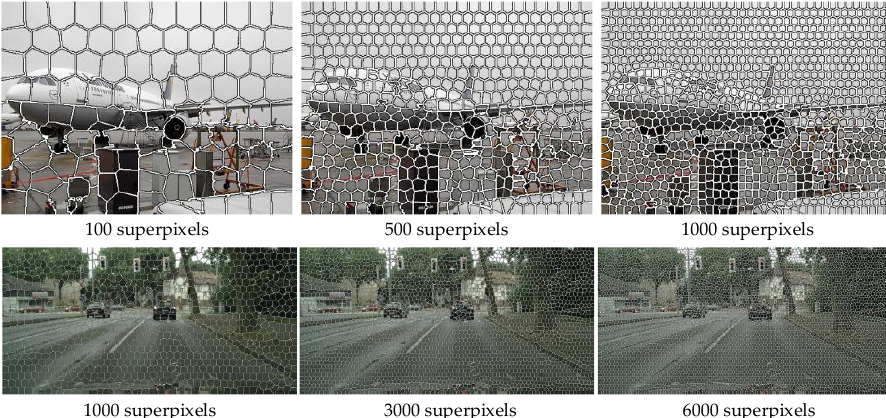
Figure 7. Results with different superpixel number. The first row: SLIC segmentation results with 100, 500, and 1000 superpixels on an example image in VOC dataset. The second row: SLIC segmentation results with 1000, 3000, and 6000 superpixels on an example image in Cityscapes dataset.